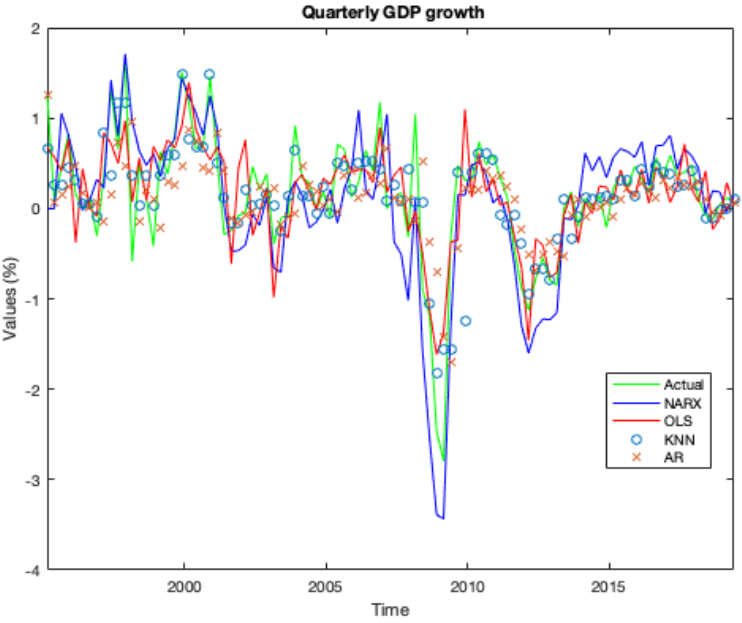
Figure 12. Italian GDP growth rate and the values forecasted by NARX, OLS, KNN and AR models for the period from 1995:Q1 to 2019:Q2 (Data source for GDP growth rate: OECD.Stat, 2019, ‘own